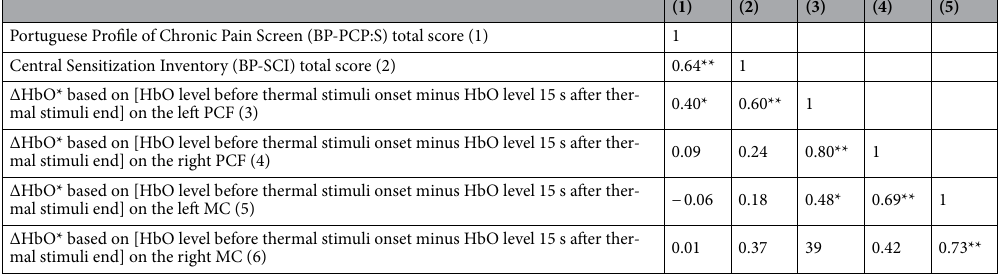
Table 4. Spearman correlation coefficients of the relationship between fibromyalgia symptoms with the delta value of oxyhemoglobin (ΔHbO*) as cortical deactivation measure in either PFC or MC (n = 22). Prefrontal cortex (PFC); motor cortex (MC). Correlation is significant at the 0.01 level (2-tailed); ΔHbO* in millimolar (mM). **Correlation is significant at the 0.05 level (2-tailed).